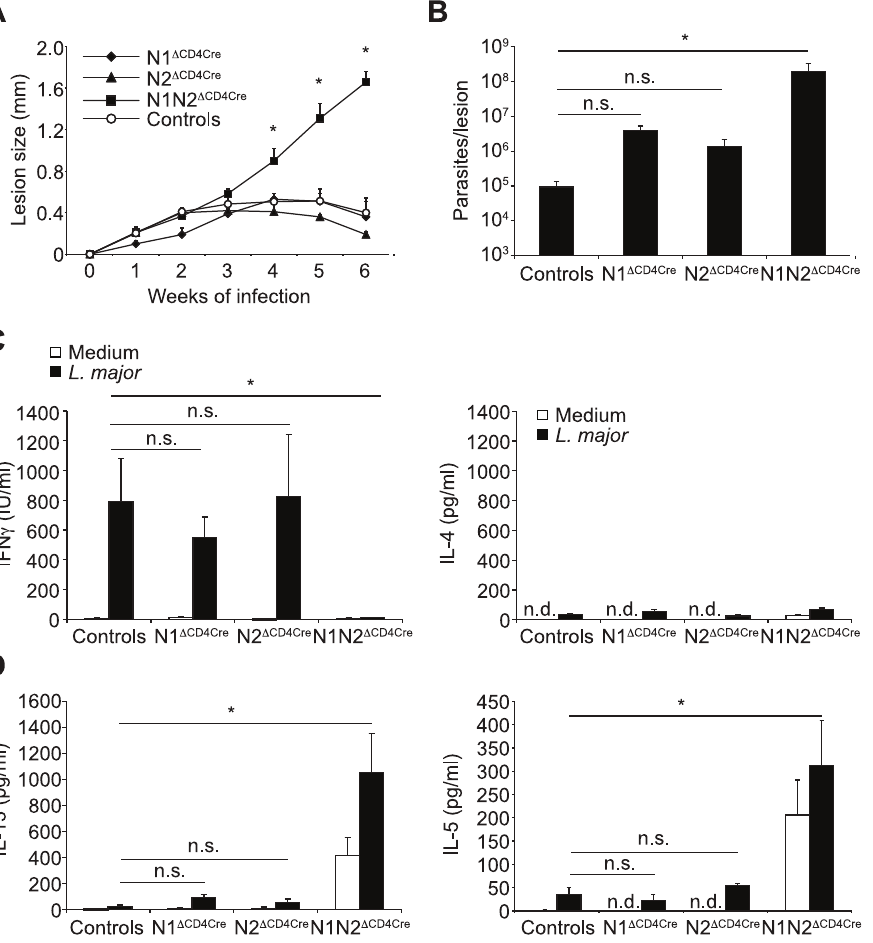
Figure 2. N1 and N2 alone can drive CD4 + Th1 differentiation. (A) N1 D CD4Cre , N2 D CD4Cre , N1N2 D CD4Cre , and control mice were infected with 3 6 10 6 L. major promastigotes and lesion size measured weekly. Data are represented as the mean of lesion size 6 SEM with n $ 3 mice per group. (B) Parasite load in the lesion was assessed by LDA 6 weeks after infection. Mean parasite number is given 6 SEM (n $ 3 mice per group) (C, D) Six weeks after infection, IFN c (C), IL-4 and IL-13 (D) secretion was assessed in supernatant of dLN cells restimulated or not with UV-irradiated L. major for 72 h. Histograms show the mean cytokine secretion 6 SEM (n $ 3 mice per group). n.d. not-detectable, n.s. not significant. * p-value , 0.05 versus control